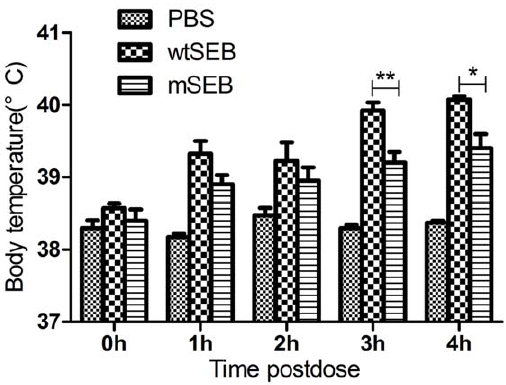
Figure 7. Pyrogenicity of wtSEB and mSEB proteins in a rabbit model. Rectal temperatures of rabbits (n=4) were monitored for 4 h and the mean temperature increase calculated. PBS was used as a negative control. mSEB versus wtSEB group: * P , 0.05, ** P ,